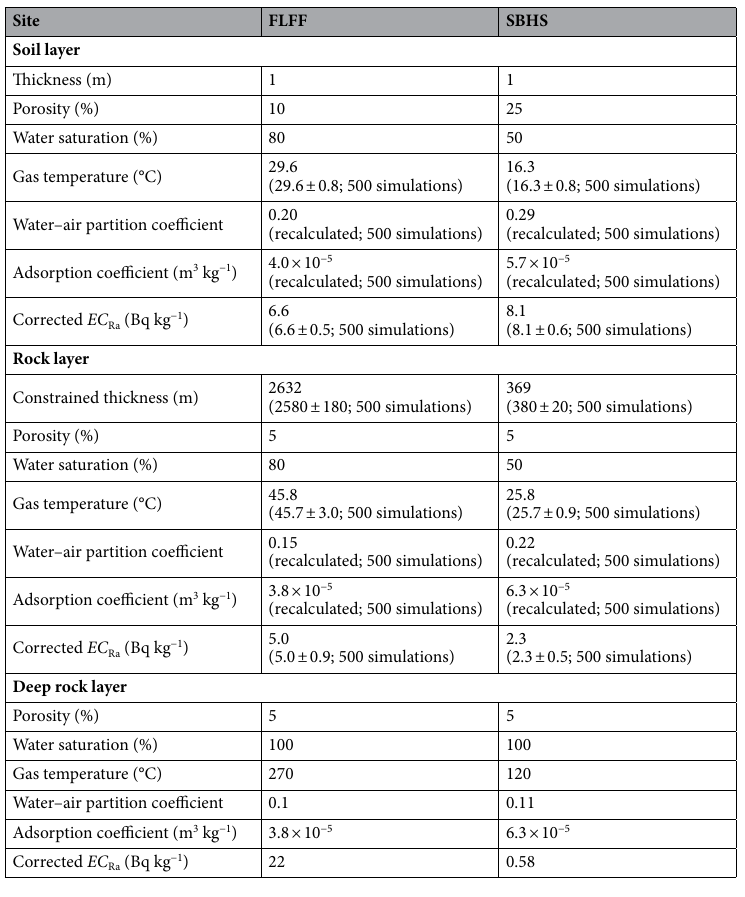
Table 3. Parameters used in the advective–diffusive model of radon transport separately for FFLF and SBHS. The thickness of the rock layer, constrained by 500 simulations, gives an estimate of the depth of degassing (see